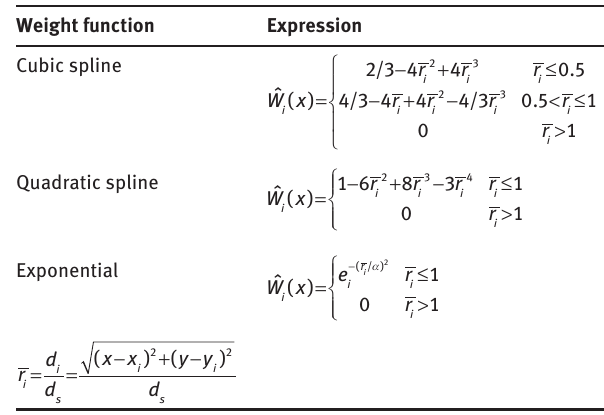
Table 1 Some possible weight functions in the